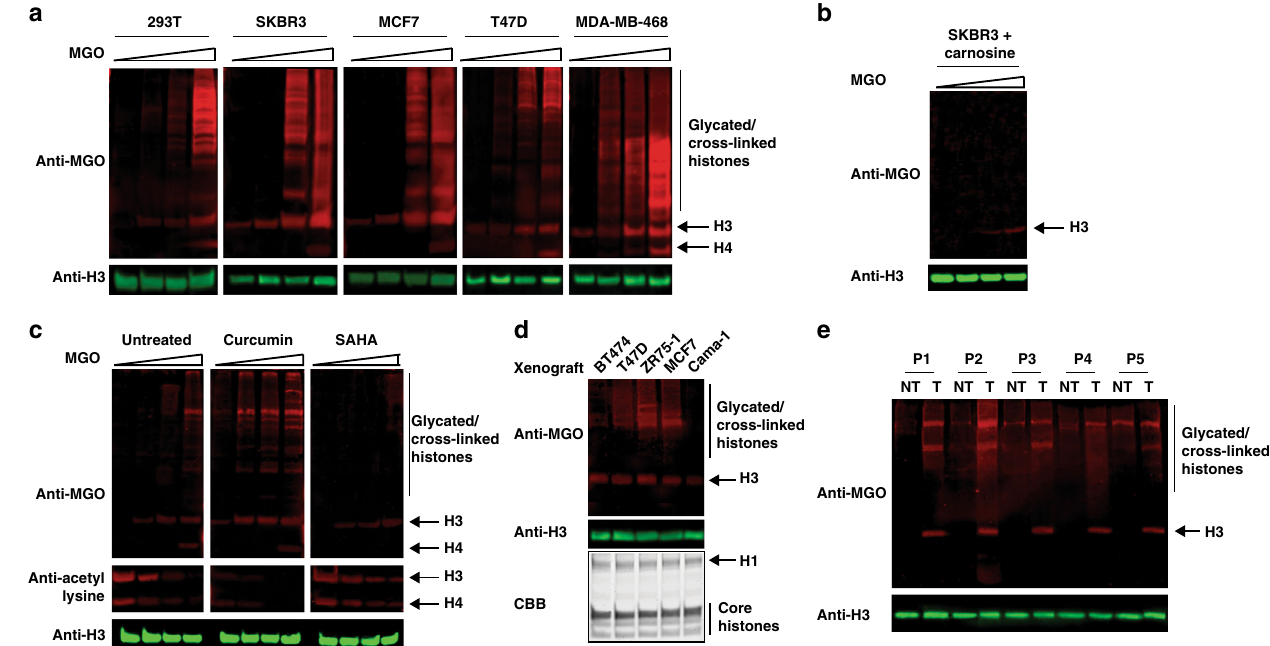
Fig. 6 Breast cancer cells and tumors display high basal histone glycation and sensitivity to MGO. a Indicated breast cancer cell lines (and 293T as a reference) were untreated or treated with 0.25, 0.5 or 1 mM MGO for 12 h, after which histones were extracted by high salt and analyzed by western blot on the same SDS-PAGE with the indicated antibodies. b SKBR3 breast cancer cell line was pre-treated for 2 h with 10 mM carnosine, after which increasing amounts of MGO were added to the media. Histones were extracted as described above and samples were analyzed by western blot with anti-MGO. c 293T cells were pre-treated with histone acetyl-transferases (curcumin, 50 μ M) or deacetylases (SAHA, 5 μ M) inhibitors for 2 h after which increasing amounts of MGO were added to the media. Histones were extracted as described above and samples were analyzed by western blot with the indicated antibodies. d Indicated breast cancer xenografts tumors were analyzed for histone glycation, by extracting the histones with high salt and analyzing them by western blot with the indicated antibodies. Corresponding cytosolic glycation analysis and DJ-1 expression can be found in Supplementary Figure 11. e Non-tumor (NT) and tumor (T) samples were obtained from fi ve different breast cancer patients (P1-P5) and both soluble and histone fractions were extracted and analyzed as described above. Corresponding DJ-1 expression levels are found in Supplementary Figure